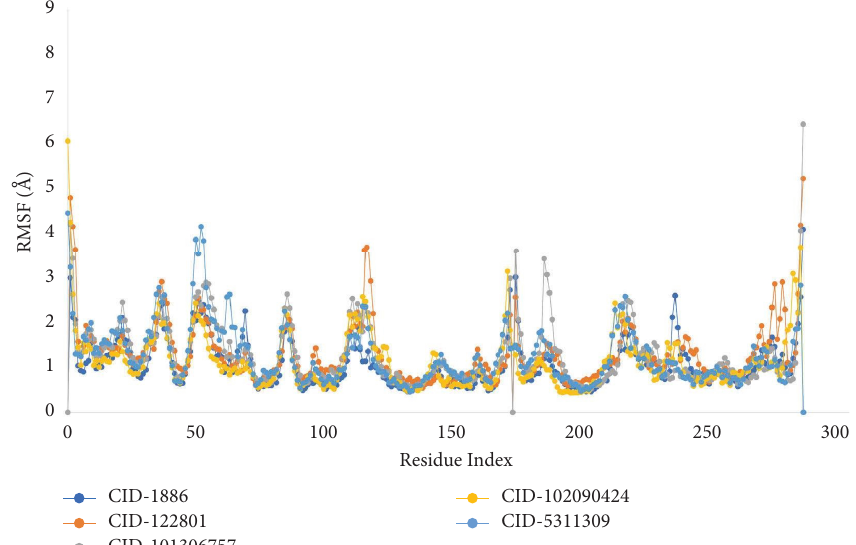
Figure 3: Te graph displays the RMSF values for the 1i44 protein model using 4 ligand compounds and 1 control drug that were recovered from the C atoms of the complex system. Te markers blue, orange, gray, yellow, and light blue are used to depict the selected compounds and had the CIDs 1886, 122801, 101306757, 102090424, and 5311309,